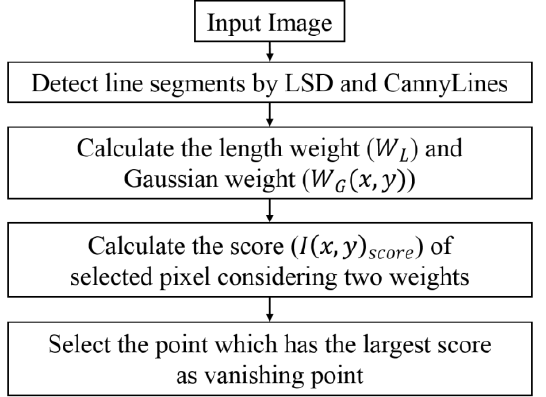
Figure 4. Overall procedure of detecting vanishing point.